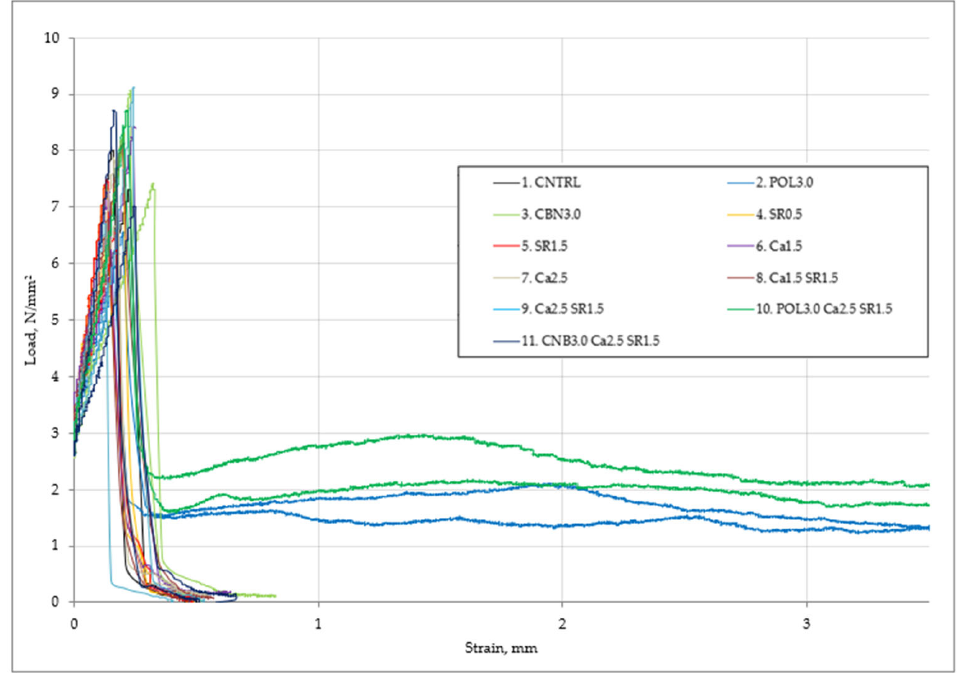
Figure 8. The function of stress and CMOD of concrete. Table 4. Fracture energy used to break the